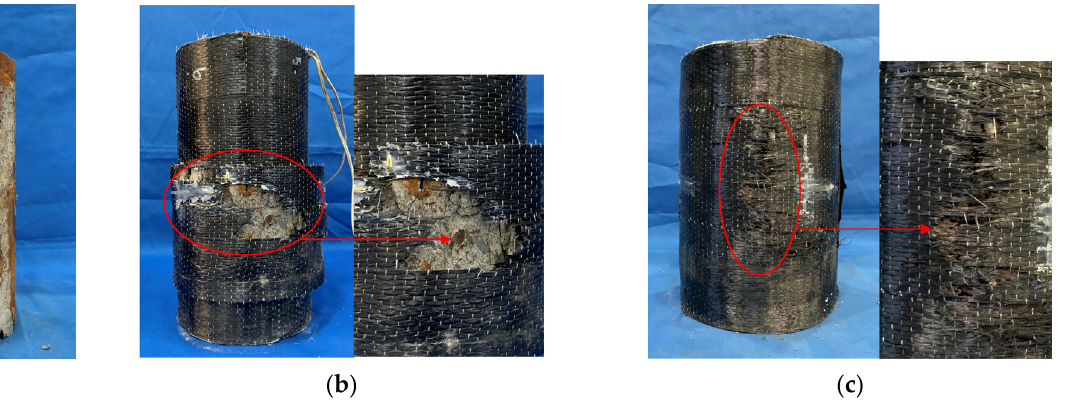
Figure 6. Failure pattern of each specimen: ( a ) URC group, ( b ) CRC group, ( c ) JRC